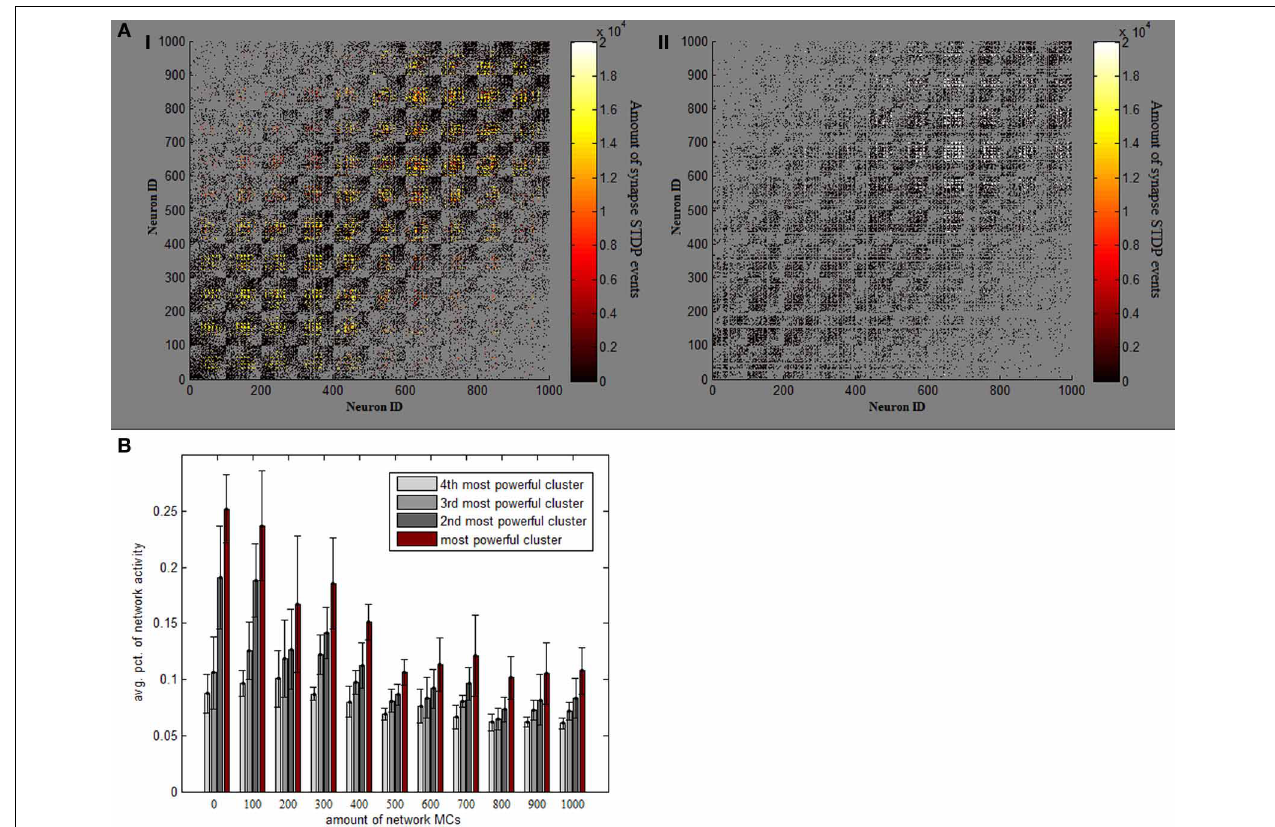
FIGURE 3 | Effect of MC inhibition. (A) Temperature plots indicate the amount of STDP events which each synapse underwent in one full 1000 neuron simulation, on network connectivity matrices. Panel I (on the left) depicts a standard simulation, while panel II is an example of a simulation lacking MC inhibitive pathway. Removing MC ruins the even spread of STDP